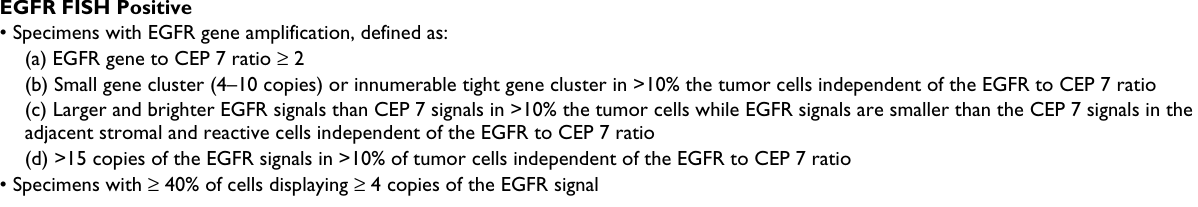
Table 2: UCCC criteria for stratification of NSCLC patients according to the EGFR FISH assay. EGFR FISH